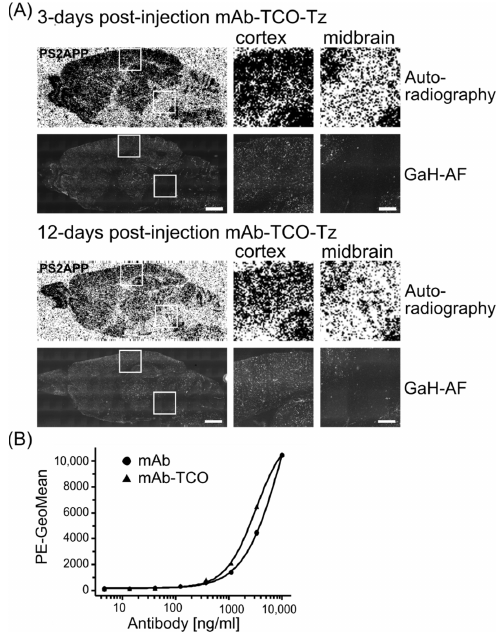
Figure 4. Maintained TfR binding and brain uptake of mAb–TCO–Tz. ( A ) Autoradiography of brain sections from PS2APP animals, 3-days and 12-days post-injection of mAb–TCO–Tz in vivo, showed a clear signal in A β -plaque-containing regions. Colocalization between the radioactive signal (autoradiography) and the mAb (GaH-AF) was visualized, using immunohistochemistry stainings, in the cortex, hippocampus, thalamus, and other A β -containing brain regions. Scale = 1 mm, magnification scale = 200 µm. ( B ) For completeness, a FACS analysis proved a slight influence of the TCO coupling on the mAb binding (mAb–TCO, triangle) to the TfR as compared to the non-modified mAb (circle). 2.4. Conjugated TCO Remains Reactive towards Tz after In Vivo Injection After confirming the preserved affinities of mAb–TCO in in vitro and in vivo experiments, the interval between antibody injection and radiotracer application, i. e., the optimal pretargeting interval and the persistence of TCO functionality over time, were analyzed. Upon treatment of PS2APP and WT control animals with 20 mg/kg mAb–TCO, animals were sacrificed after four different time points (1-, 3-, 6-, and 12-days post- injection), and their brains dissected. As anticipated, the TCO-modified antibody passed the blood–brain barrier and bound to A β plaques in the expected brain regions (including cortex, hippocampus, and thalamus), as demonstrated by immunofluorescent detection of the mAb–TCO antibody (Figure 5). The mAb–TCO construct entered the brain in a comparable manner as the unconjugated mAb (comparison see Supplemental Figure S5). Brain sections were incubated with the Tz in order to test the reactivity of the TCO moiety